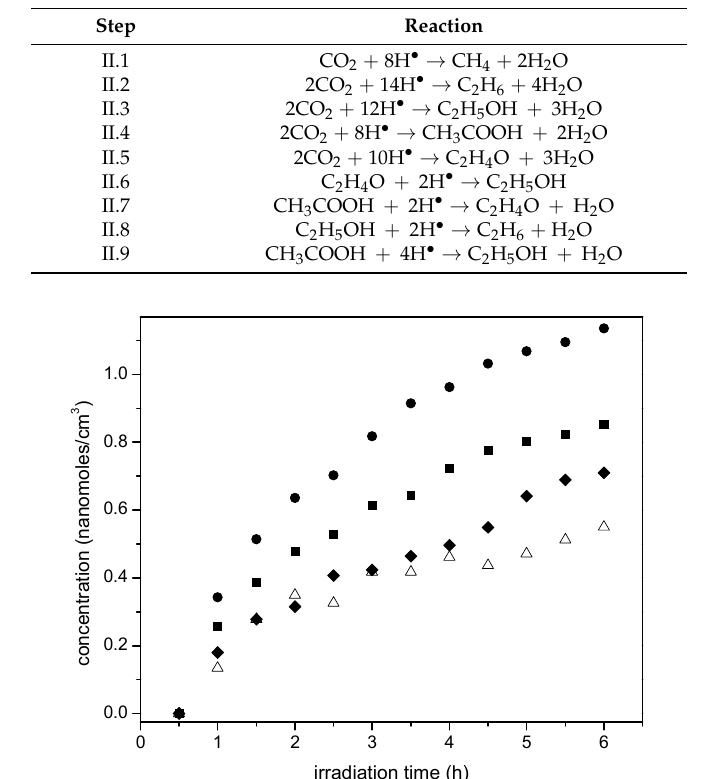
Table 5. Proposed reduction reactions on Pt sites.